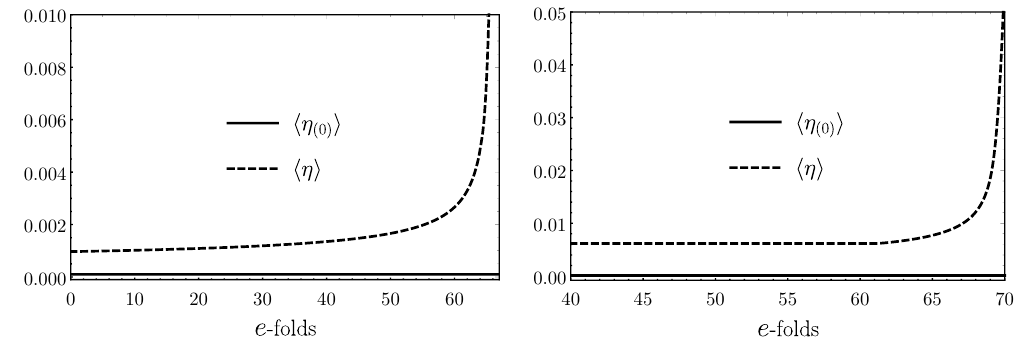
Figure 5 . Evolution of (cid:17) for set 1 (left) and set 2 (right). While the averaged (cid:17) parameter is zero in the absence of backreaction, including the dependence of the K(cid:127)ahler moduli on the in(cid:13)aton gives rise to a small but non-zero